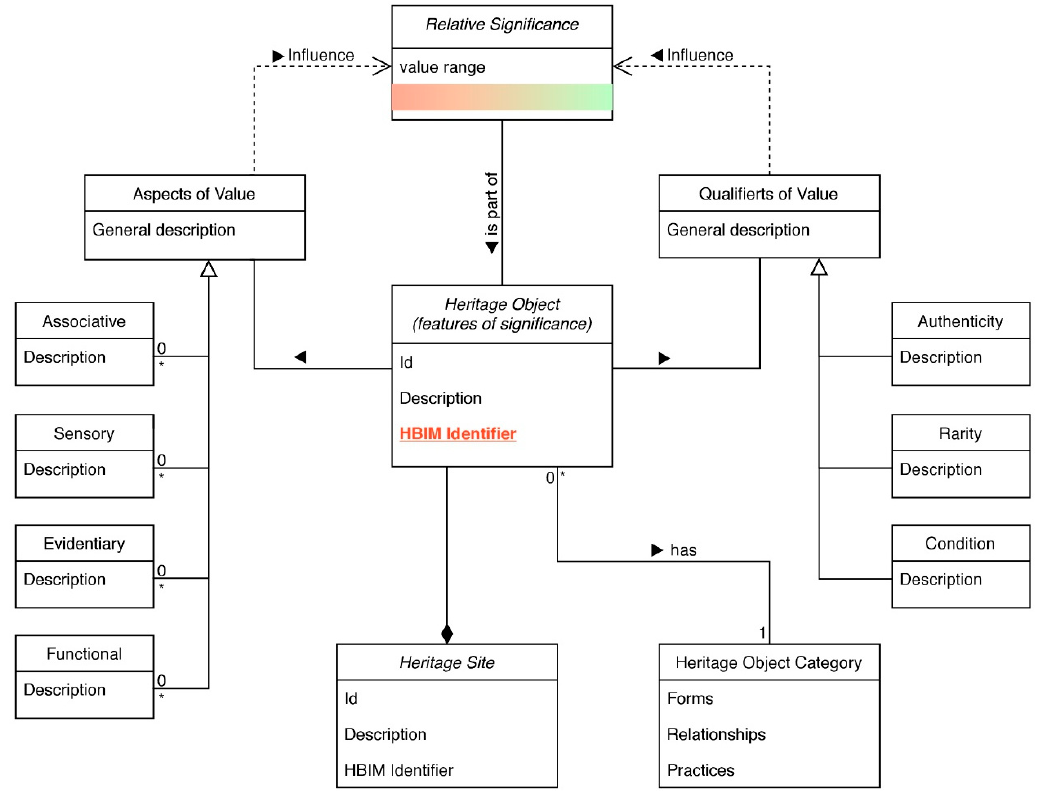
Figure 7. Conceptual model proposed for the structuring of heritage objects’ significance in data models. At the centre of the model, the heritage object, contained in one or several heritage sites, has to be associated with the appropriate category. Then the description of the associated values and the general significance of the elements have to be provided. Together with the qualifiers of value, which enable evaluating the perceptibility of each value, they help stakeholders to define the relative significance of the heritage object using a value scale.